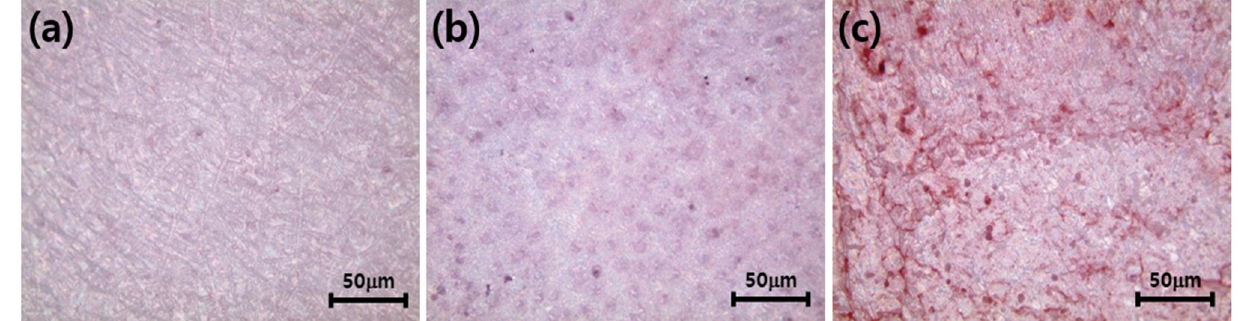
Figure 12. Alizarin red staining of MC3T3-E1 cells cultured on pristine ZrO 2 ( a ), ZrO 2 -HA ( b ) and ZrO 2 -HA-Col ( c ). Cells were cultured for 21 days in circular zirconia disks placed in wells of a 24-well culture plate. After removing the medium, the adhered cells were fixed with 10% formaldehyde aqueous solution. Thereafter, alizarin red staining was performed on the cultured cells. Digital images were captured with an optical microscope equipped with an advanced camera.